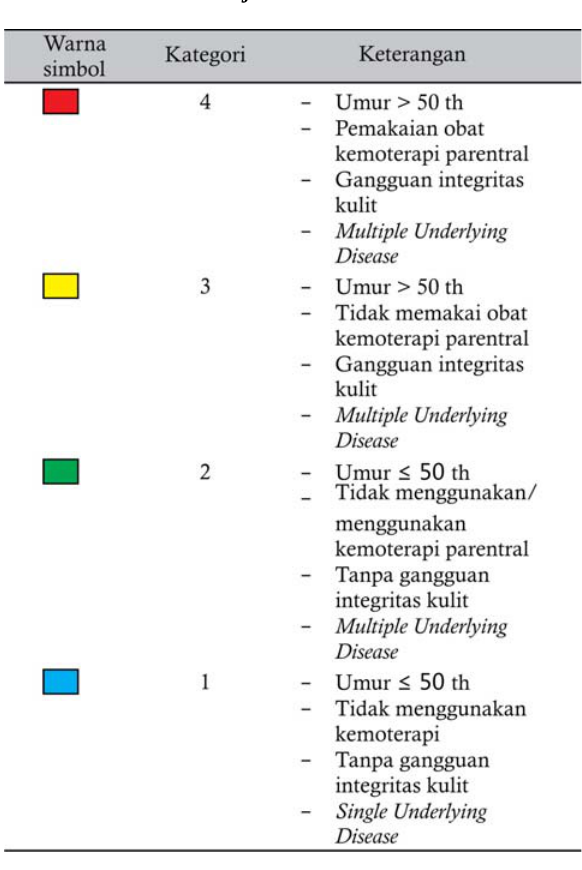
Kriteria Kejadian